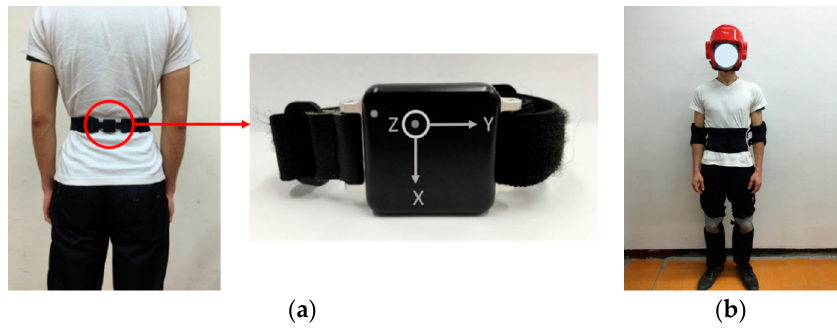
Figure 1. ( a ) Wearing position and the axial direction of sensor; ( b ) Schematic view of the participant